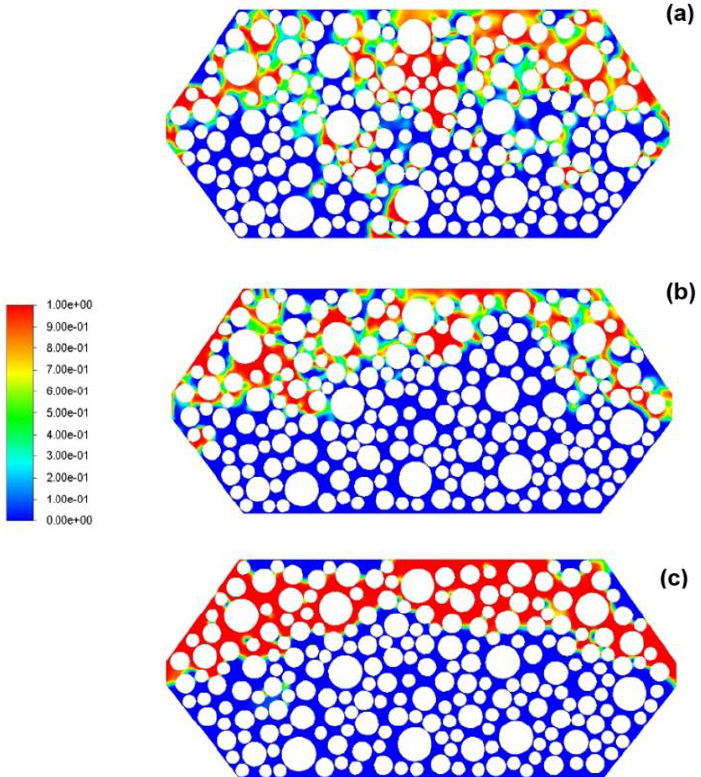
Figure 11. Comparison of oil displaced at 300 s for ( a ) 0.034 N/m (case 1), ( b ) 0.017 N/m (case 2), and ( c ) 0.005 N/m (case 3). The blue region represents the volume fraction of oil, and the red represents the volume fraction of APG.